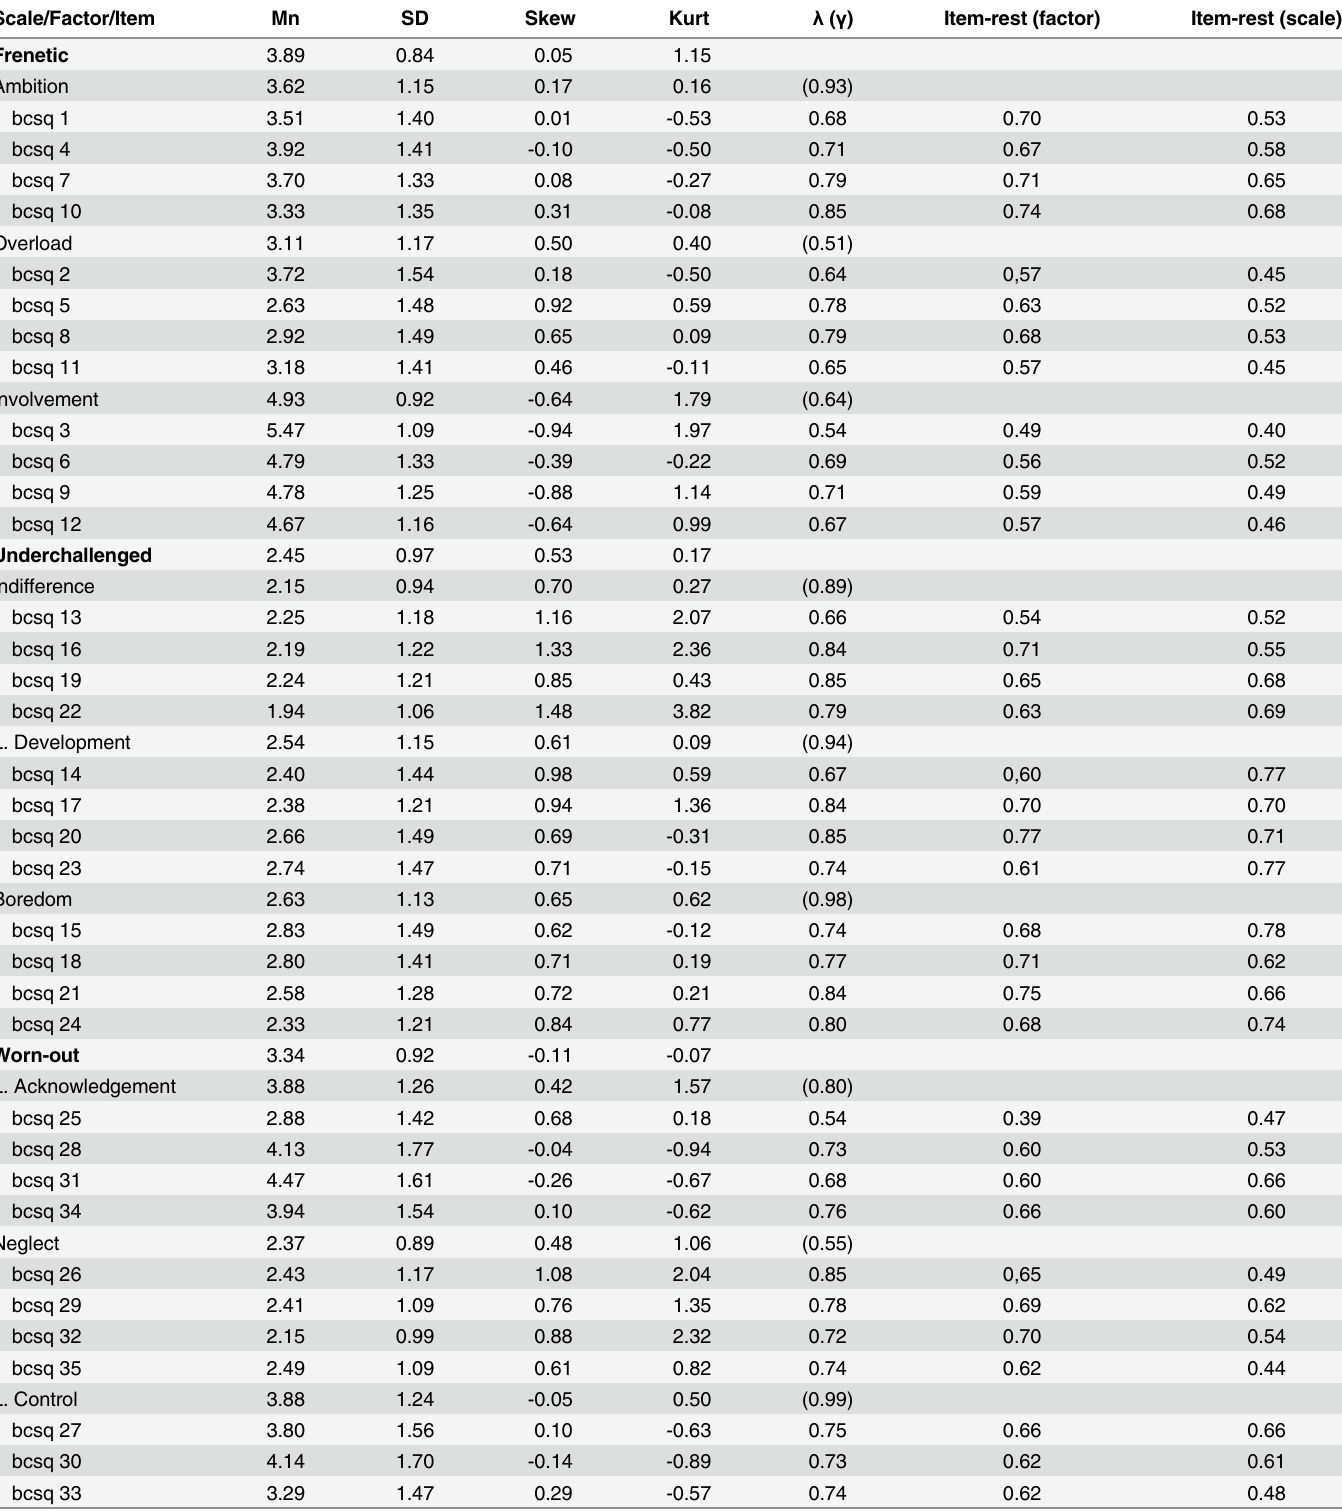
Table 1. Psychometric characteristics of the